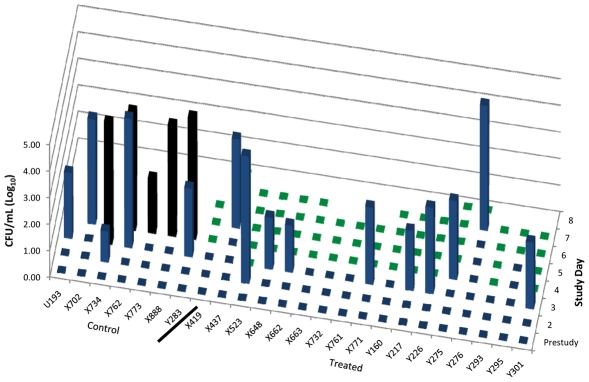
Pre-infusion and post-infusion bacteremia in controls and treated AGM.Quantitative bacteremia prior to and after initiation of levofloxacin (treated, N = 16) or D5W (control, N = 7) infusions. Blue bars indicate level of bacteremia prior to infusion. Black bars indicate level of bacteremia post-infusion for control animals and green bars for treated AGM. Nine AGM did not have bacteremia detected prior to infusion with D5W (N = 2) or levofloxacin (N = 7).